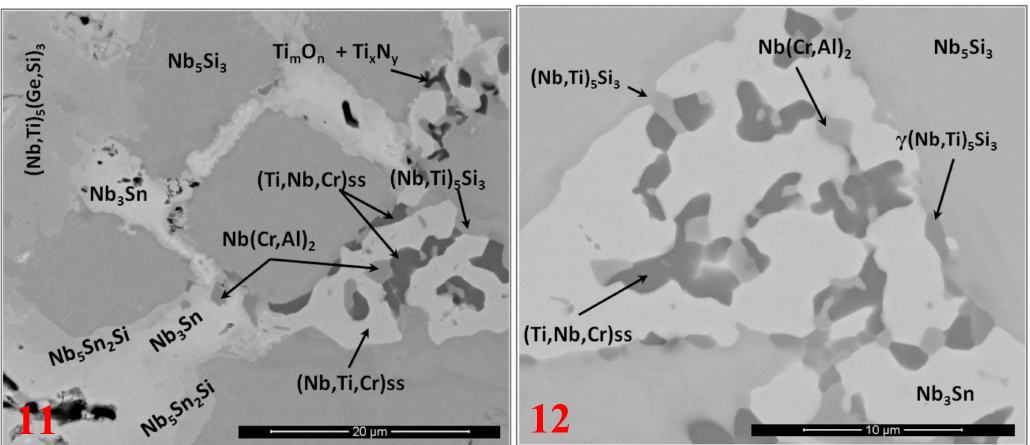
Figure 13. Images of cross-sections of the alloy OHS1 after isothermal oxidation in air at 1200 ◦ C: ( a ) SE, ( b ) BSE. The red numbers are related to the following BSE images: ( c ) #1 oxide scale (OS), ( d ) #2 OS, ( e ) #3 OS, ( f ) #4 OS, ( g ) #5 OS, ( h ) #6 OS, ( i ) #7 di ff usion zone (DZ), ( j ) #8 DZ, ( k ) #9 DZ, ( l ) #10 DZ, ( m ) #11 DZ, and ( n ) #12 bulk of the alloy after oxidation. For yellow box in ( b ), see Figure 14.